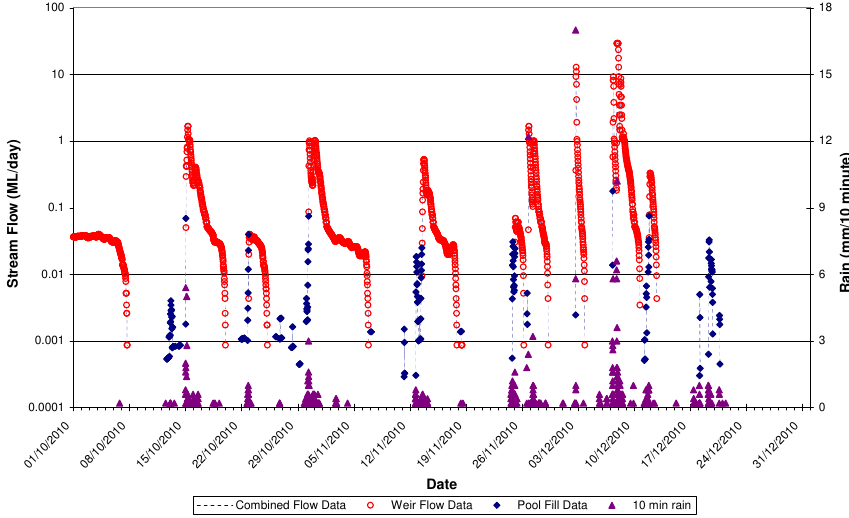
Fig. 6. Stream flow (30min intervals) and rainfall (10min intervals) at the catchment weir site. Open red circles show stream flow from the weir rating curve. Solid blue diamonds show flow calculated from increases in pool volume at levels lower than the weir